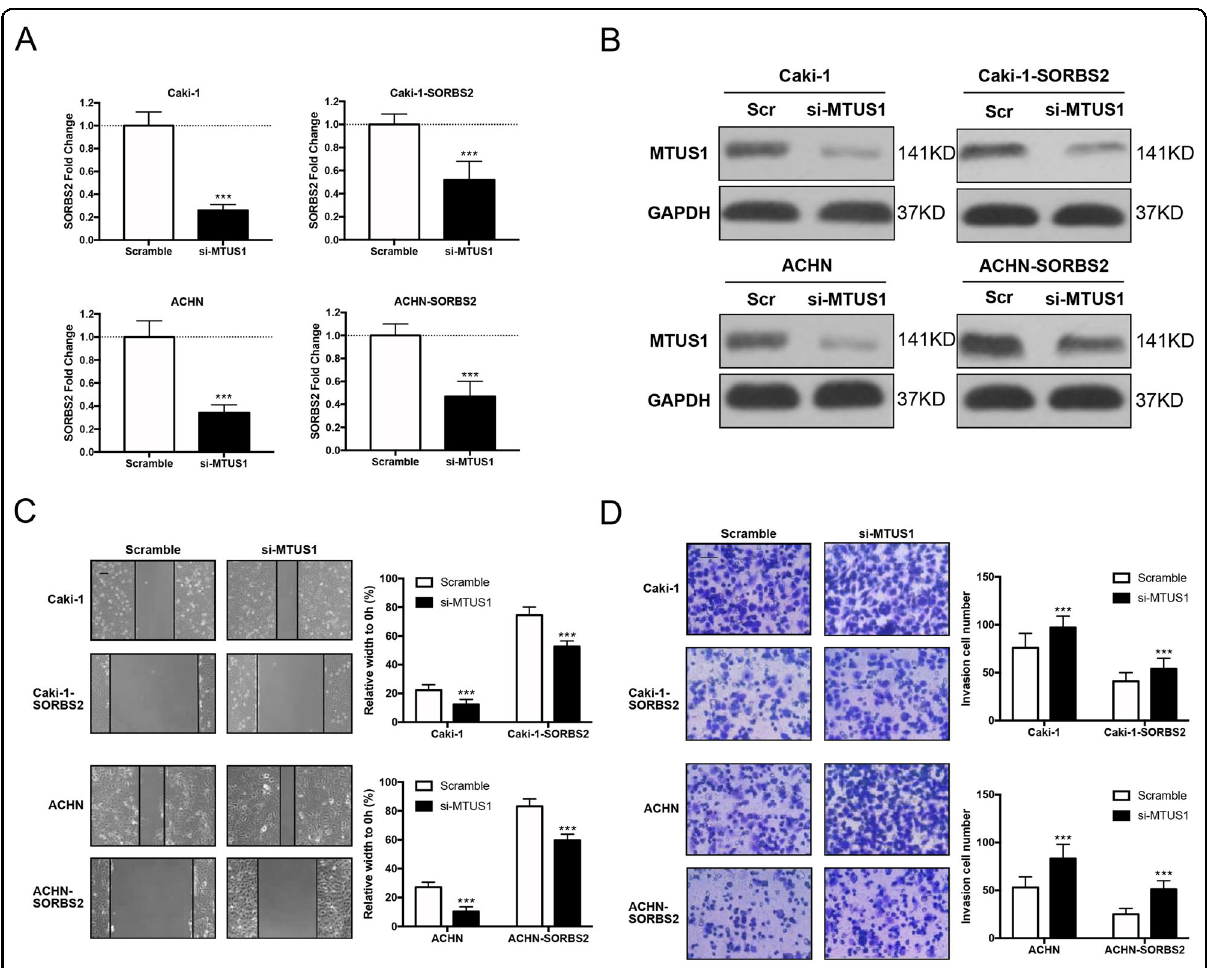
Fig. 5 Knockdown of MTUS1 attenuated SORBS2-mediated metastasis suppression. A , B qRT-PCR and western blot analysis of MTUS1 knockdown in ccRCC cell lines. C , D Wound healing and Transwell assay, scale bar = 20 μ m. *** P <